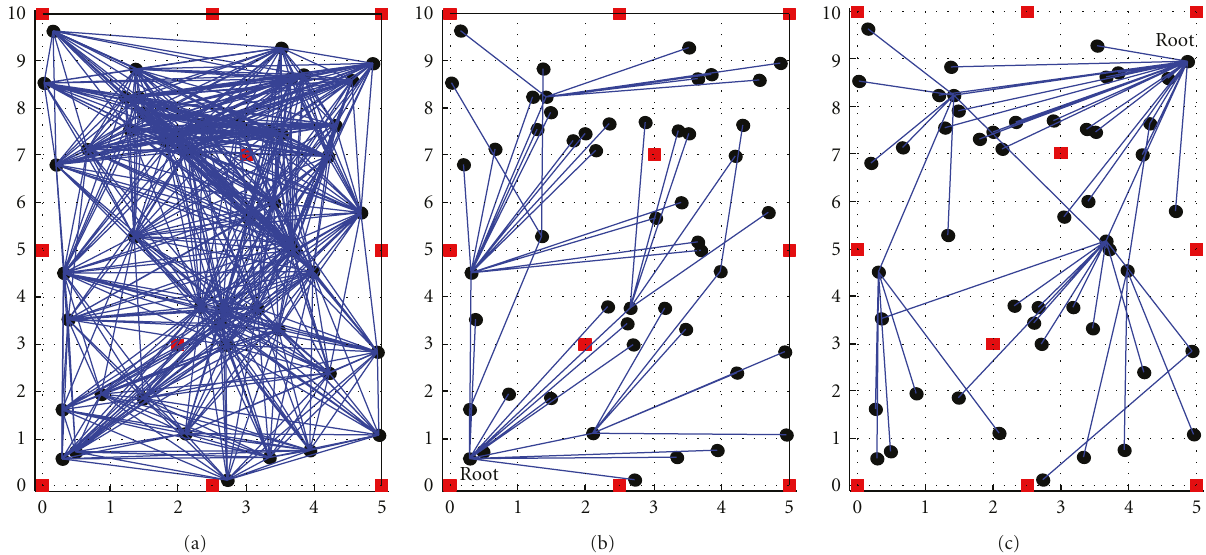
Figure 10: (a) Original network, (b, c) two corresponding spanning trees. Connections between anchors (marked by red squares) and unknowns (marked by black circles) are not